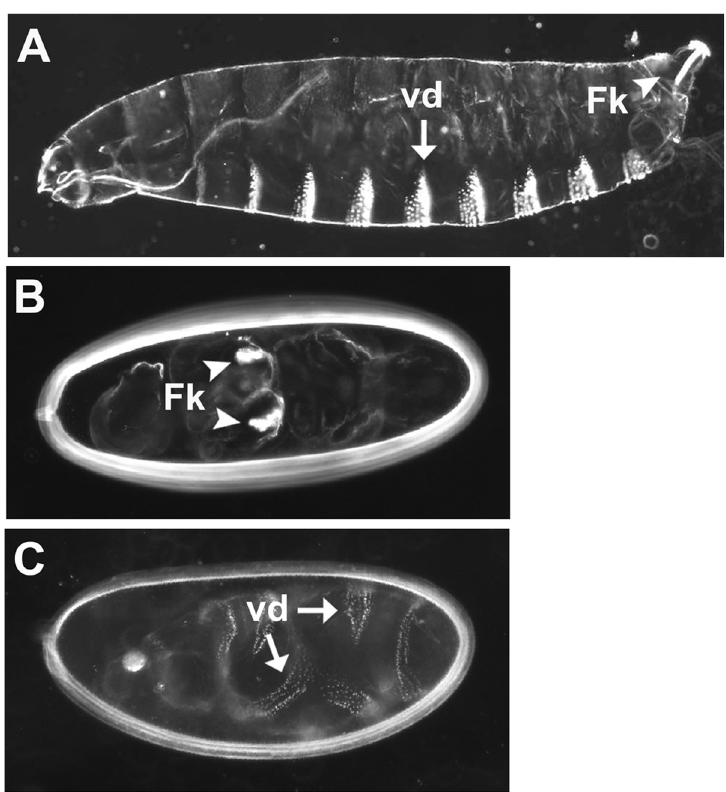
Fig 4. BAP-tagged versions of the Tsl and GD proteins are functional. (A) Wild-type first instar larval cuticle showing ventral denticle bands (vd, arrow) and Filzko¨rper (Fk, arrowhead) structures. (B) Embryonic cuticle produced by a mother expressing Tsl-BAP throughout the follicle cell layer under the control of the CY2-Gal4 driver element. As seen previously with wild-type Tsl [65, 66, 75], uniform expression in the follicle cell layer leads to the formation of progeny embryos that are made entirely of terminal pattern elements. The segmented regions of the embryo are suppressed, with the loss of ventral denticles and the presence of patches of Filzko¨rper material (Fk, arrowheads) that have formed in the central region of the embryo. (C) Embryonic cuticle produced by a mother expressing GD-BAP mRNA in ovarian nurse cells under the control of the Nanos-Gal4 :: VP16 driver element. As has been seen for wild- type GD protein [76], transgenic overexpression in the female germline leads to the formation of ventralized embryos. Pattern elements that are normally found in dorsal and dorsolateral regions of the larvae, such as Filzko¨rper, are absent, while there is an expansion of ventral structures such as ventral denticles (vd, arrows) around the DV circumference of the